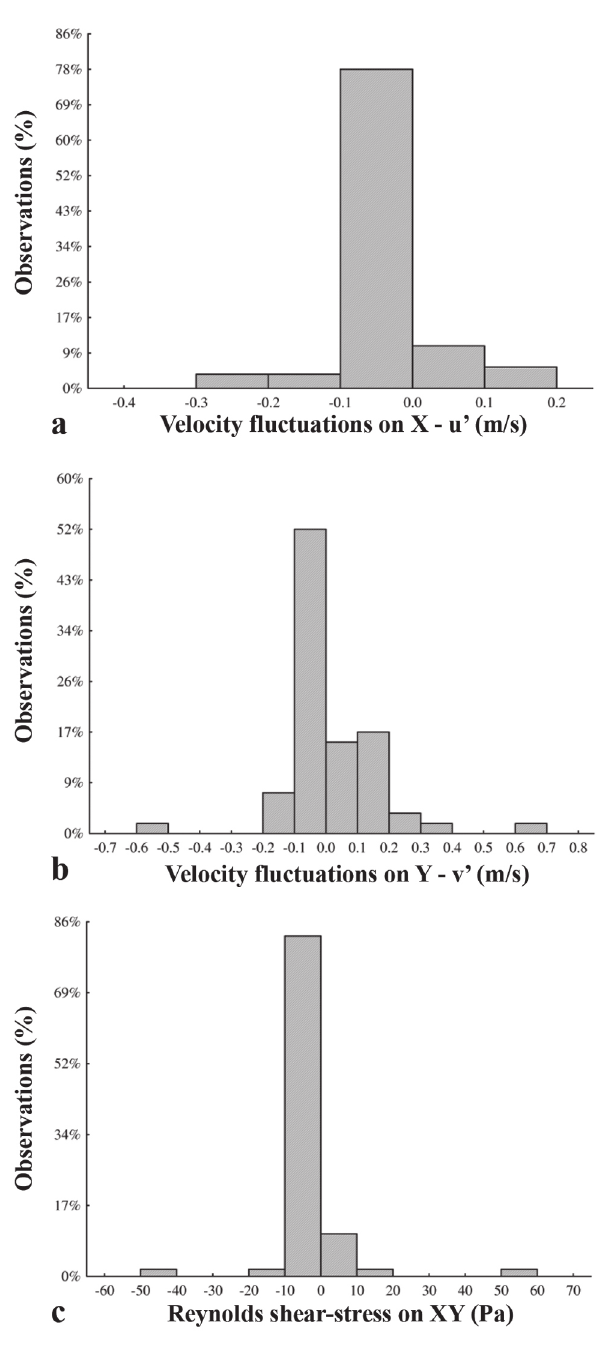
Table 1. Preferences for both species in Pool 2.Coloured cells represents different